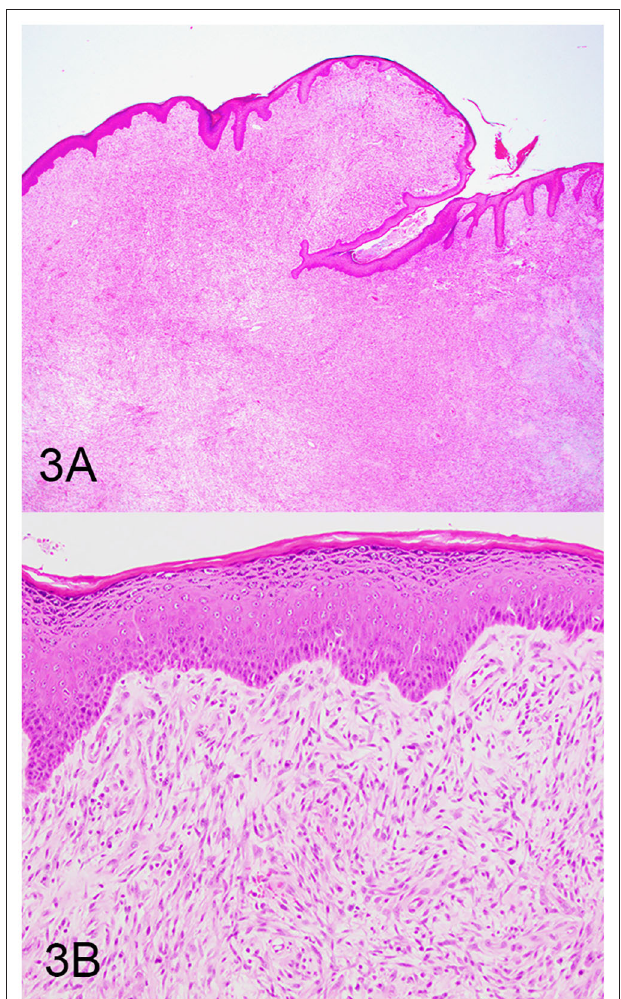
FIGURE 3 | Oral spindle cell tumor (OSCT), hematoxylin and eosin staining. (A) OSCT with no junctional activity, but the neoplastic cells are present at the epithelial–subepithelial junction, are predominantly spindloid, and have no pigment. Magnification, × 4. (B) Higher magnification of (A) highlighting neoplastic cells at the epithelial–subepithelial junction. Magnification, × 20.